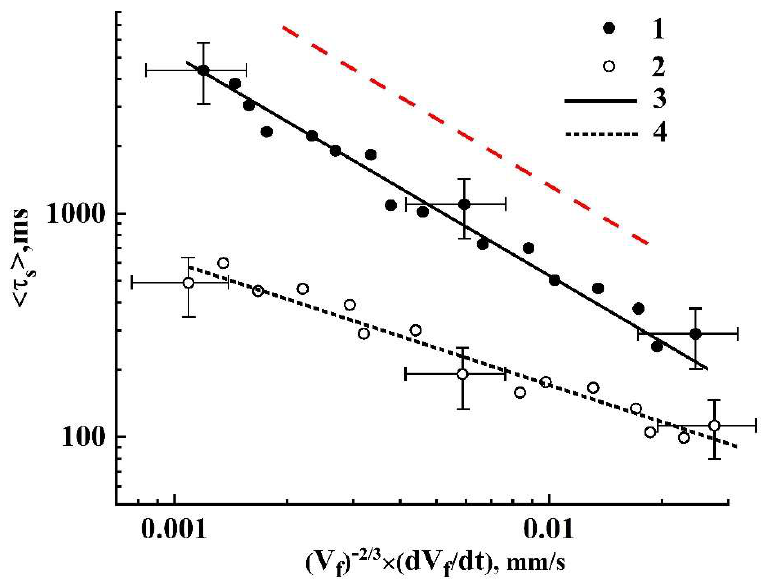
Figure 10. The average lifetime of speckles against Ψ in the cases of slow (1) and rapid (2) depressurization. Dependencies (3, 4) are the power-law fits (cid:104) τ s (cid:105) = C Ψ α for the datasets (1, 2). α 3 ≈ − (0.989 ± 0.059); C 3 ≈ (5.455 ± 2.062) ms · (mm/s) − α 3 ; α 4 ≈ − (0.571 ± 0.039); C 4 ≈ (12.426 ± 3.058) ms · (mm/s) − α 4 .